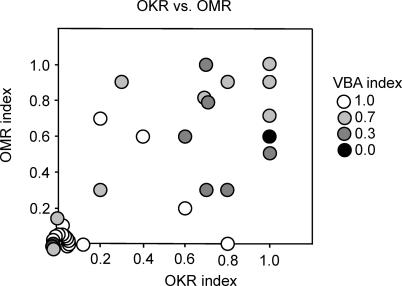
Distribution of Behavioral Phenotypes among the Three Visual ResponsesOMR index is plotted over OKR index for each mutant. Each circle represents a mutant. The shading of the circles represents the VBA index for that mutant. Only mutants with SSA index greater than 0.6 are shown. OMR is strongly correlated with OKR only for very low scores (around 0). Mildly impaired mutants are often differentially affected. OMR and OKR performance is not correlated to VBA index.